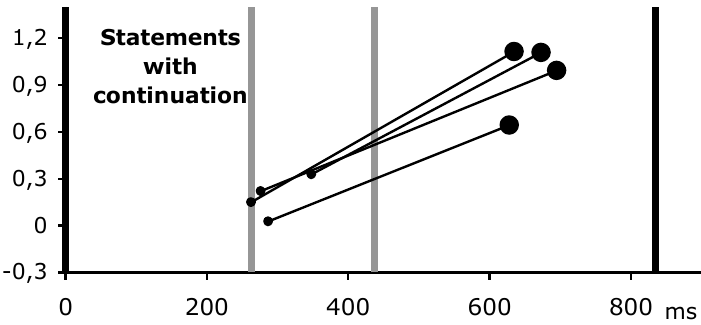
Figure 3. Statements with continuation: Here only the four tokens that show a rise are plotted. Plotting style and normalization are as in Figure